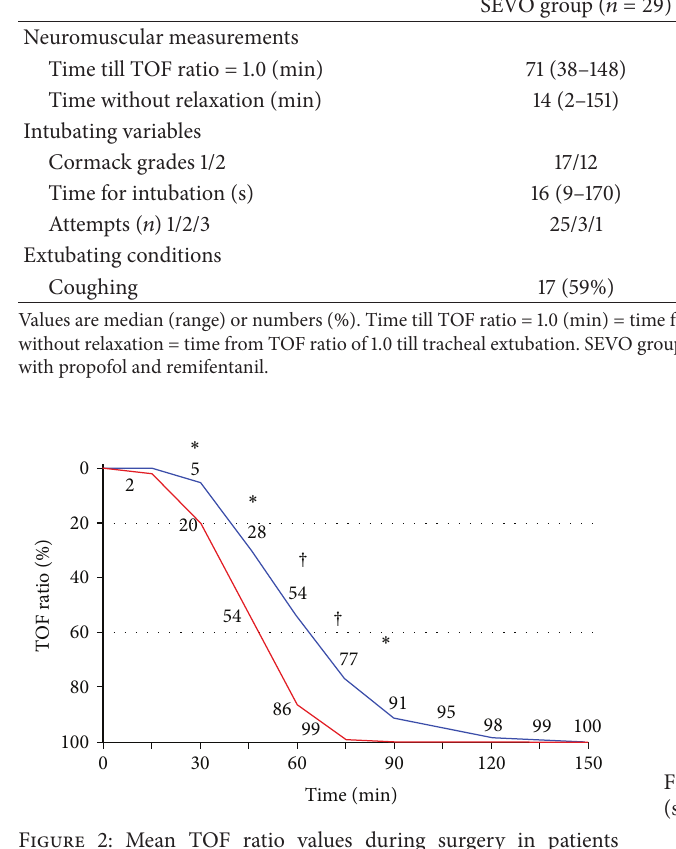
Figure 2: Mean TOF ratio values during surgery in patients receiving sevoflurane (SEVO group; upper blue line) or propofol (TIVA group; lower red line). ∗ 𝑃 = 0.003 SEVO group versus TIVA group. † 𝑃 < 0.001 SEVO group versus TIVA group.